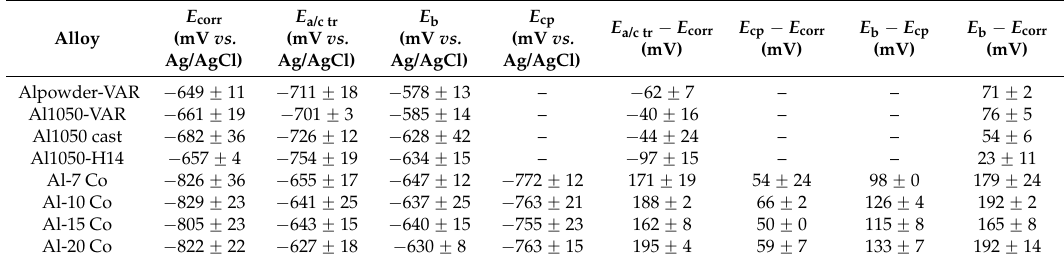
Table 3. Electrochemical values of the alloys immersed in 3.5 wt.% NaCl, at 25 ˝ C. E corr : corrosion potential; E a/c tr : anodic-to-cathodic transition potential; E cp : critical “passivation” potential (stage 2); E b : breakdown potential. (The reported values are average of four to five responses).